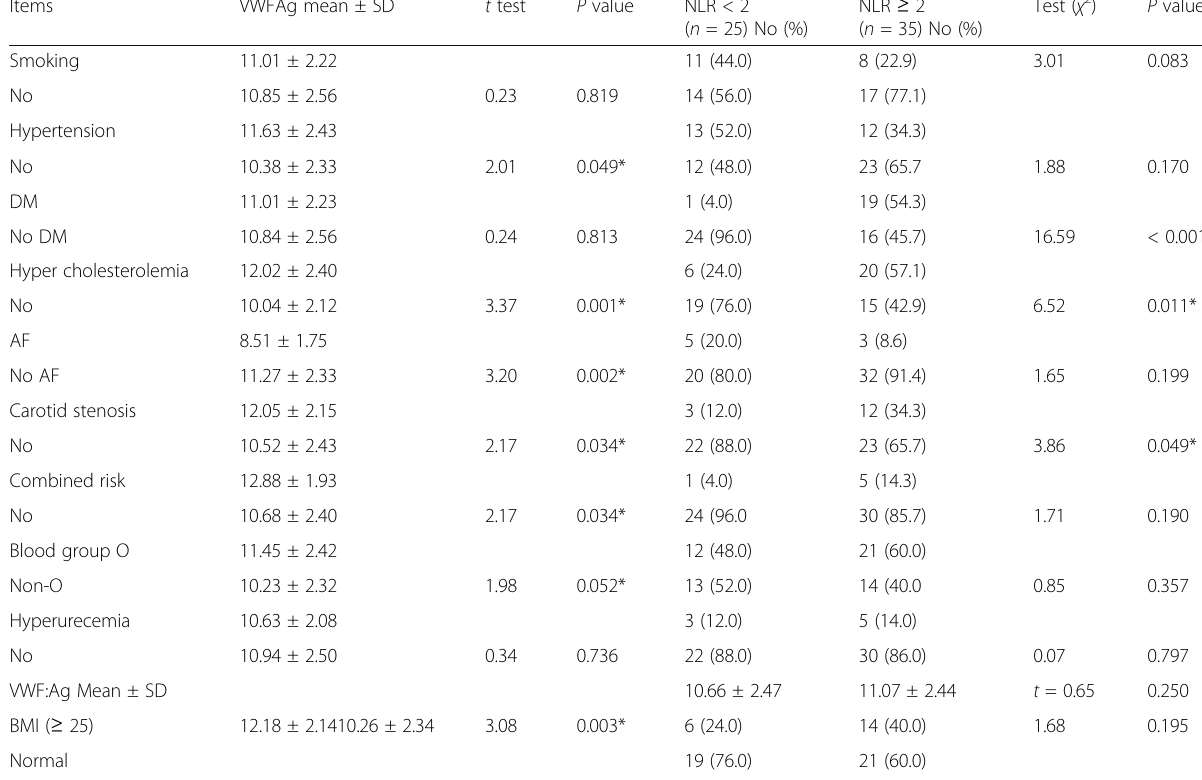
Table 3 VWF: Ag and NLR in relation to stroke risk factors among patients Items VWFAg mean ± SD t test